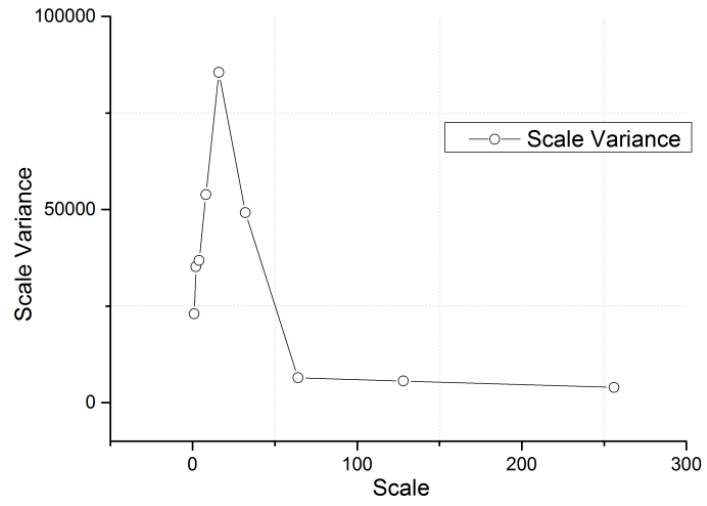
Figure 10. Scale variance graph showing the multi-scale structure of UV analysis results yielding a peak for Level 16 (480 m resolution). See text for explanation.